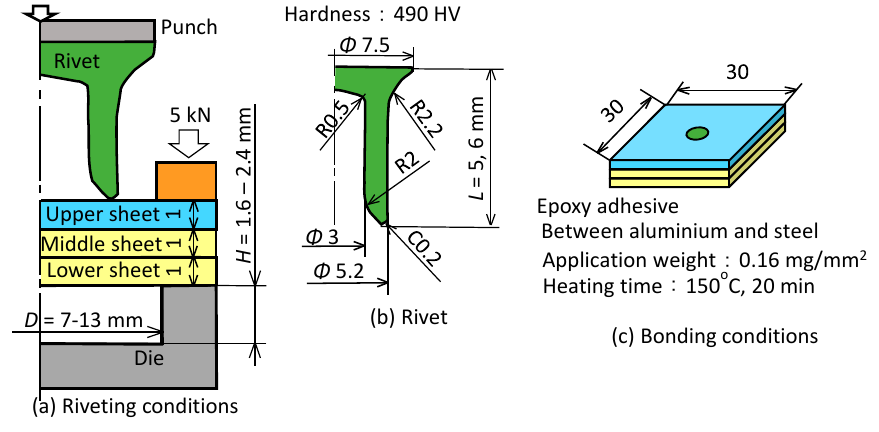
Figure 4. Self-pierce riveting conditions of three sheets: ( a ) riveting conditions; ( b ) rivet; ( c ) bonding conditions.